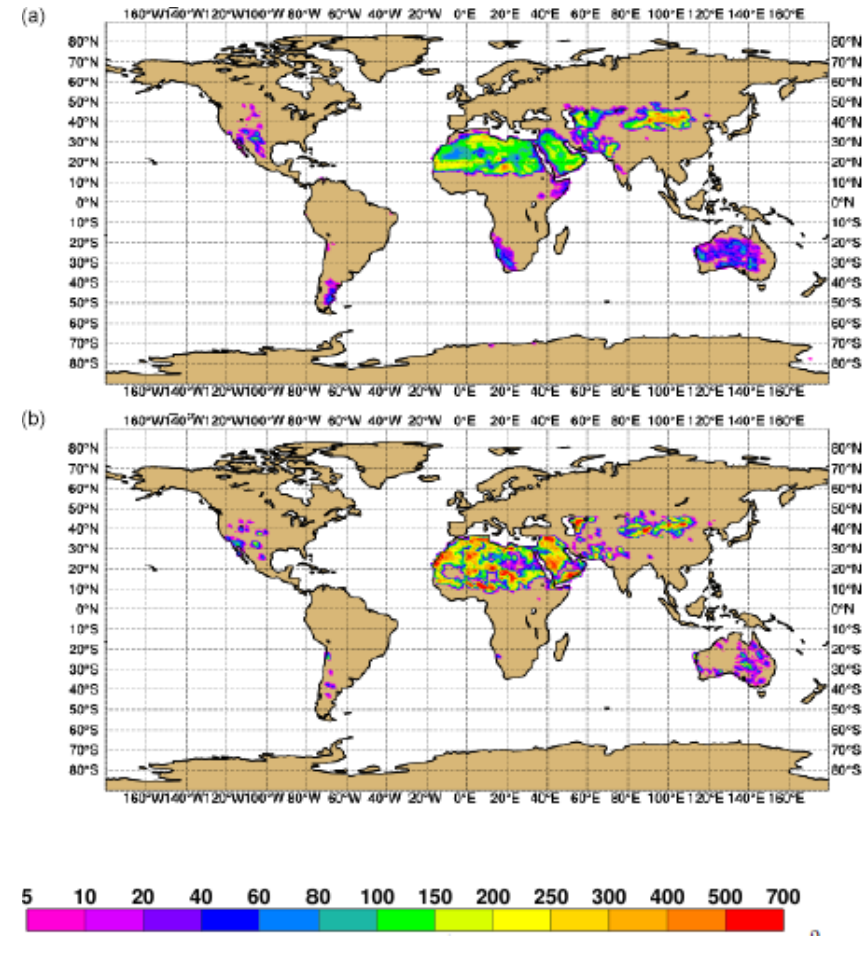
Figure 1. Annual total emissions of dust for 2017 as simulated by CY45R1 and CY47R1 (b) (in gm − 2 yr − 1